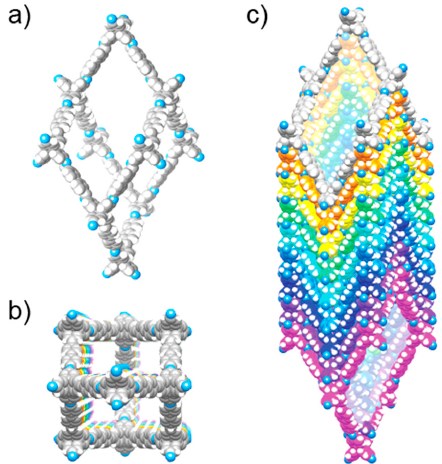
Figure 1. Crystal structure of COF-320 obtained by rotating electron diffraction (RED) at 298 K. ( a ) Adamantane-cage of the diamond net; ( b ) Representation of the nine-fold interpenetration of the diamond net, viewed along the crystallographic c -direction; ( c ) The square-shaped, one-dimensional (1D) channels running along the c -axis.